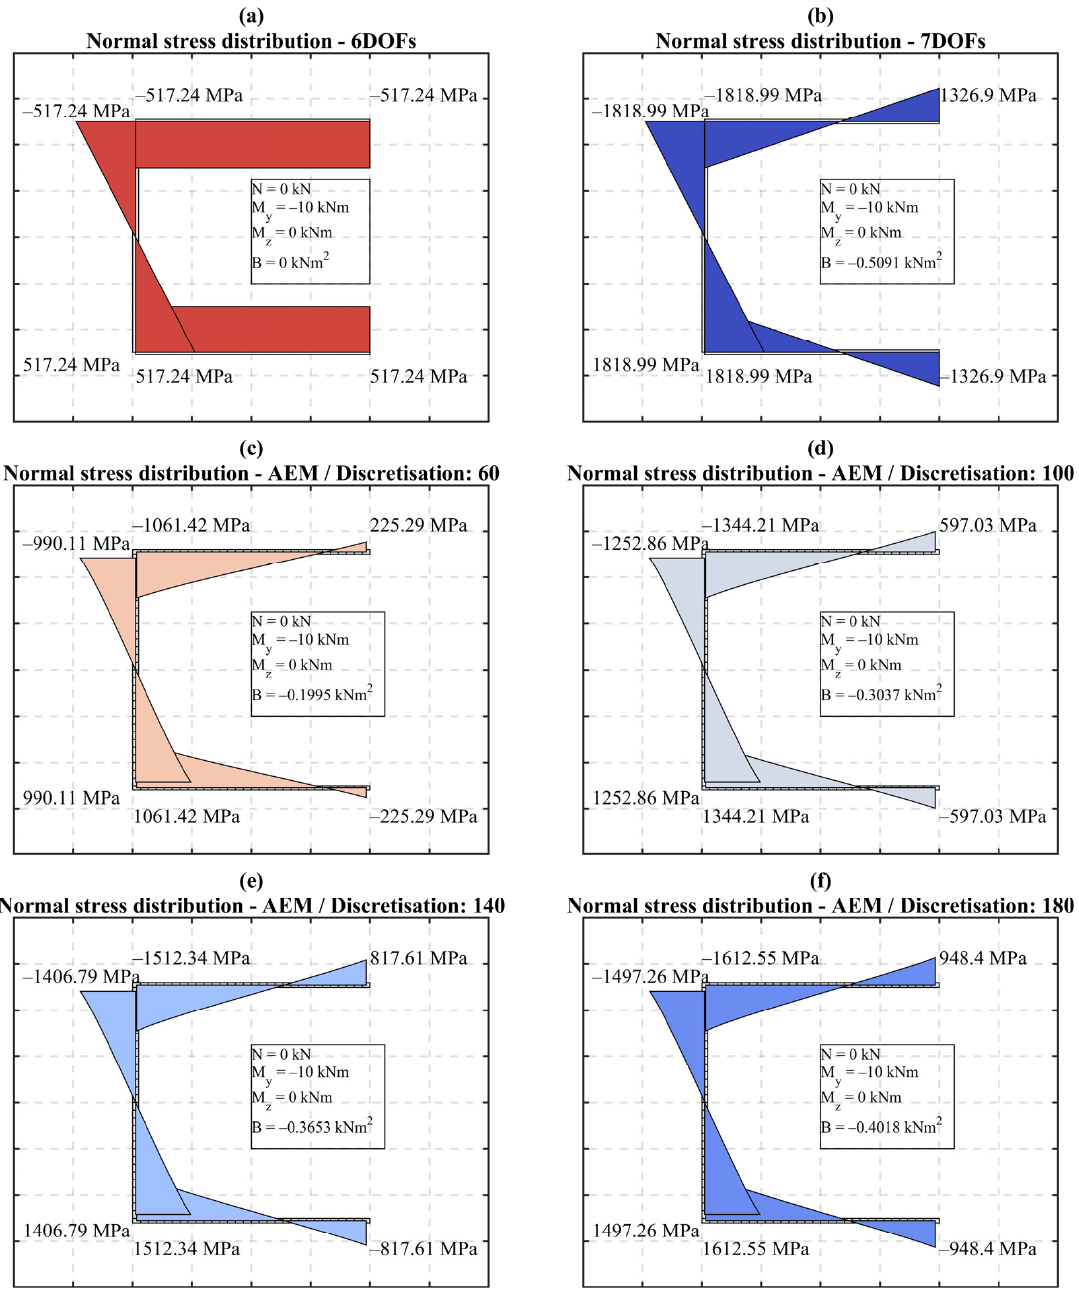
Figure 7. Normal stress distribution for Section #1, with a length L = 1000 mm and a section discretisation of 30 blocks for each section